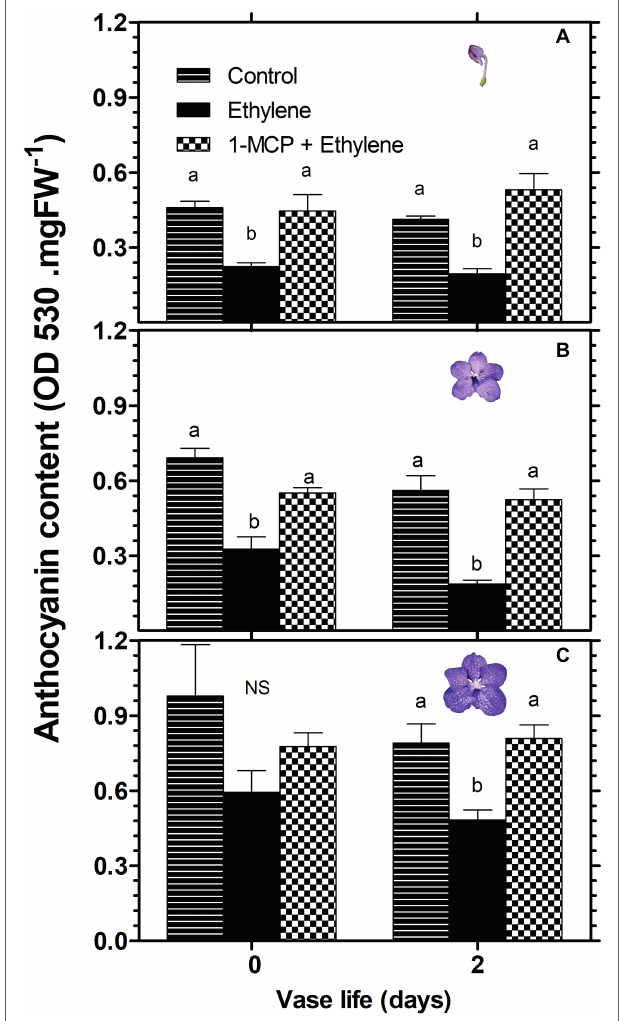
FIGURE 3 | Effect of ethylene and 1-MCP pre-treatments on changes in anthocyanin content of cut Vanda ‘Sansai Blue’ flowers at different developmental stages of colored bud (A) , half bloom (B) , and bloom (C) , during 2 days of vase life after treatments. Ethylene and 1-MCP pre-treatments were applied as detailed in Figure 2 , and florets at the indicated developmental stages were sampled and assayed spectrophotometrically for anthocyanin content. The results represent means ± SE of four floret replicates per treatment. Different letters indicate significant differences among treatments at the different time points, at p < 0.05 for day 0, or at p < 0.01 for day 2 (graph A ); at p < 0.01 (graphs B,C ); NS, not